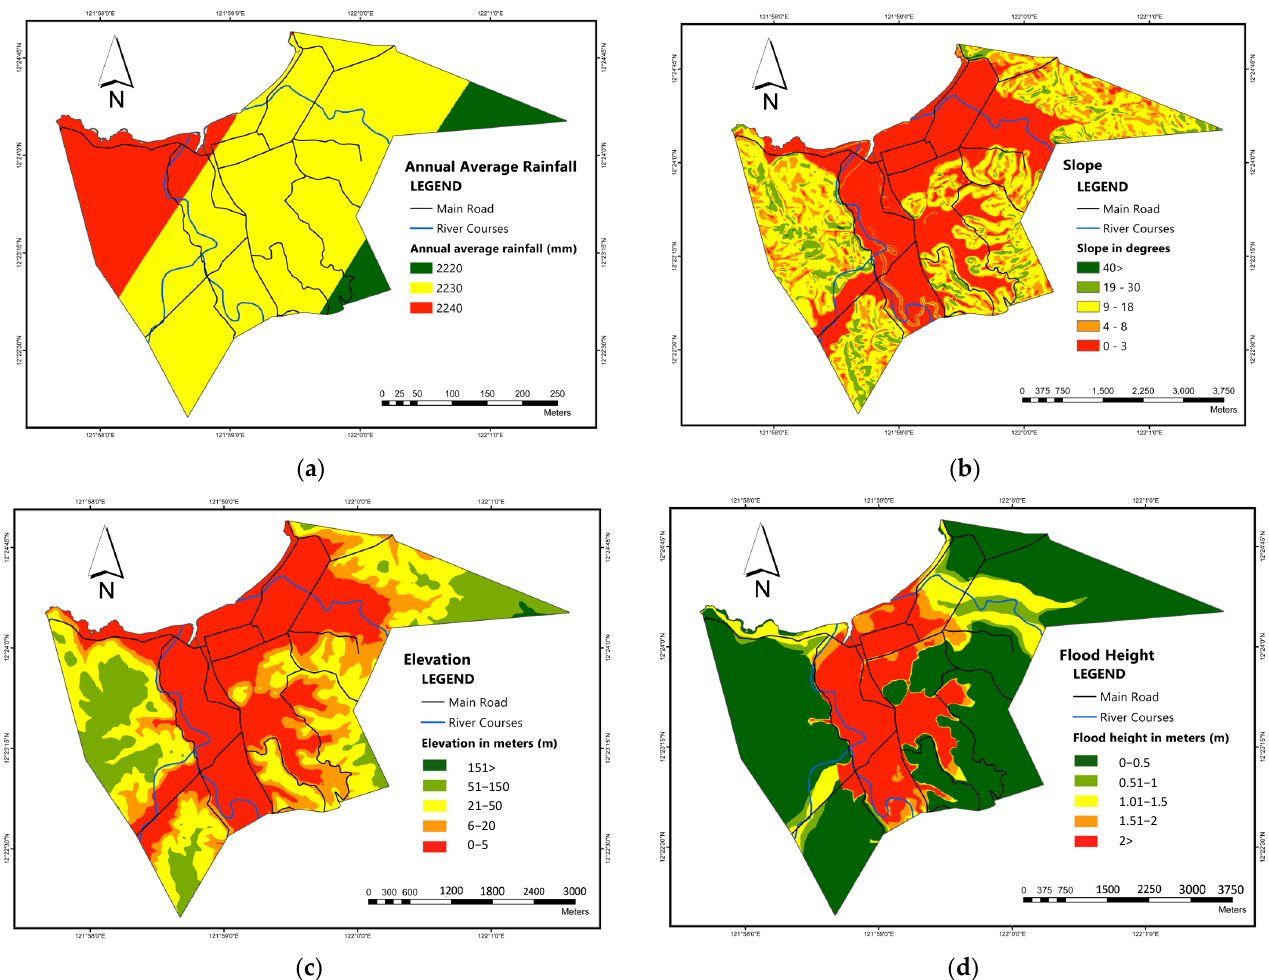
Figure 3. Generated maps from ArcMap in building flood hazard parameters: ( a ) average annual rainfall map, ( b ) slope map, ( c ) elevation, and ( d ) flood height map of the municipality of Odiongan.